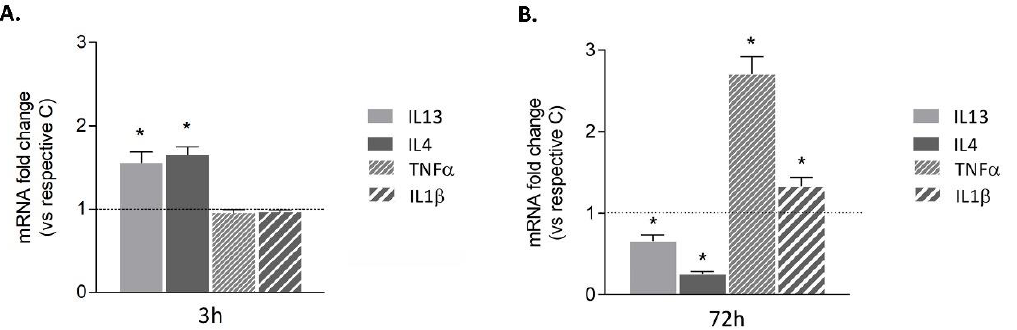
Figure 2. Time course of HMC3 microglial polarization. Cells were treated with 0.2 μM of Aβ42. 3 h ( A ) or 72 h ( B ). Expression of anti-inflammatory (IL4 and IL13) and pro-inflammatory (TNFα and IL1β) markers was investigated by qRT-PCR. Dotted lines indicate control values. Results are the mean ± SEM of three independent experiments. * p < 0.05 vs. respective control by Student’s t -test for significance.